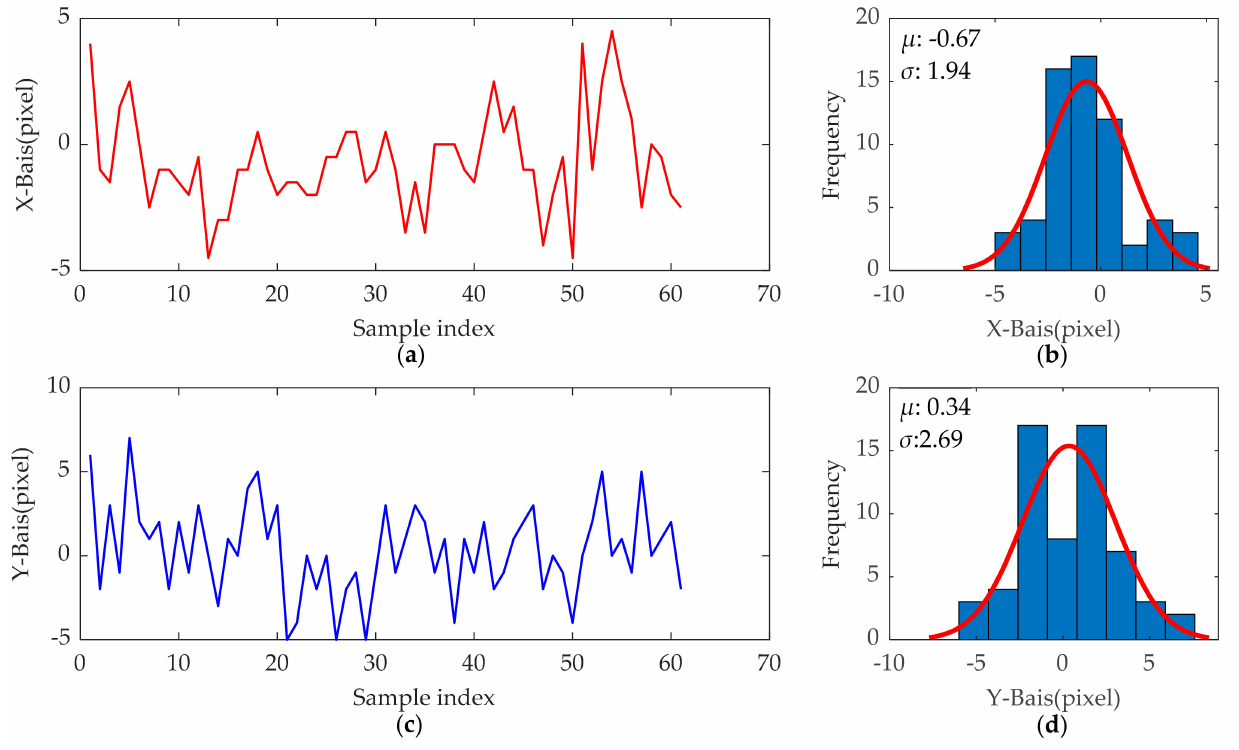
Figure 23. Statistical results of pipeline position deviations. ( a ) Deviation along the x-axis of the image; ( b ) deviation distribution along the x-axis; ( c ) deviation along the y-axis of the image; ( d ) deviation distribution along the